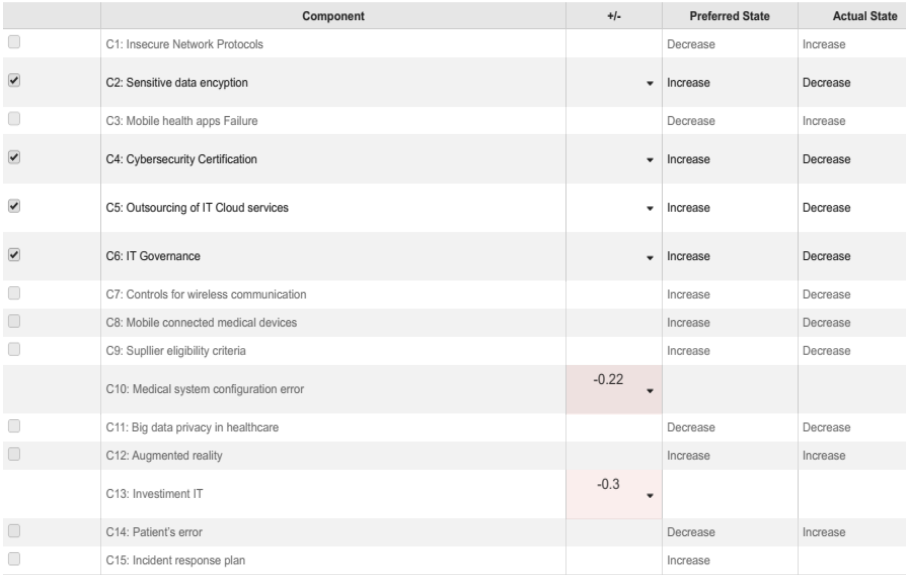
Figure 4. Final equilibrium states by the value of nodal element C10 (Medical system configuration error) and C13 (IT Investment).